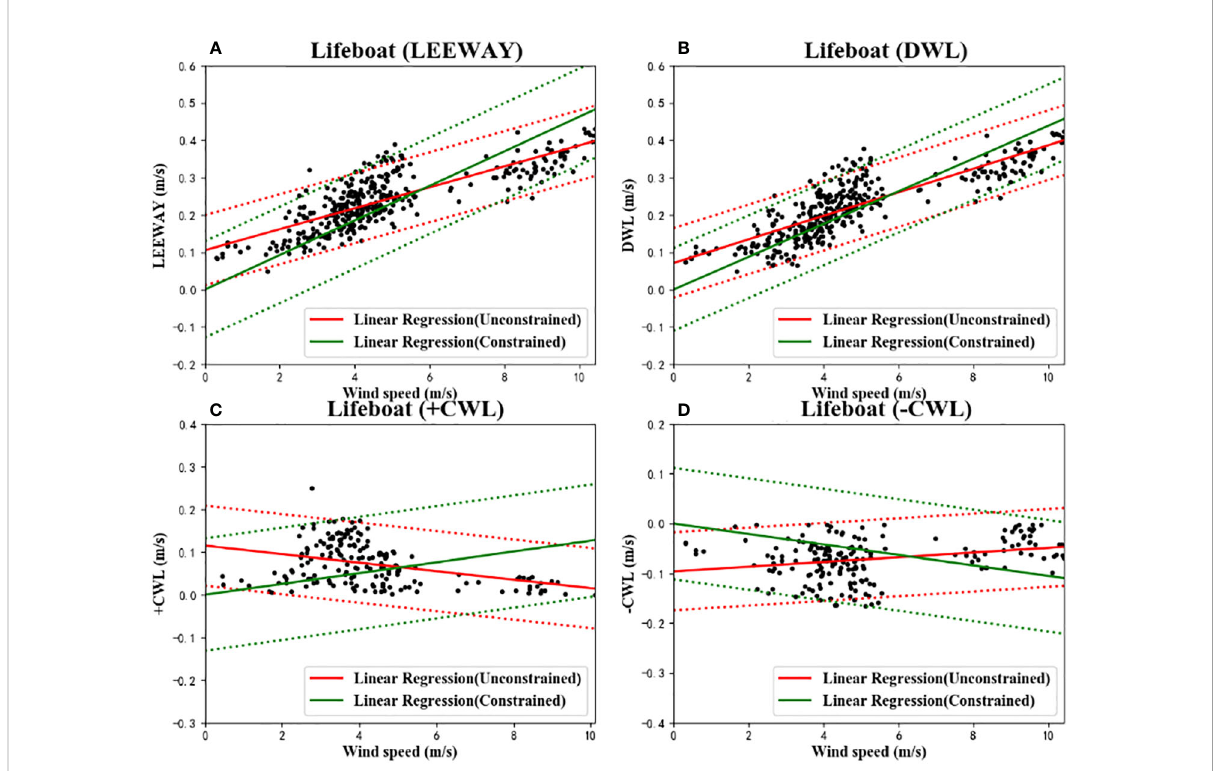
FIGURE 9 The linear regressions and 95% con fi dence level statistics of Leeway Speed (A) , DWL (B) , +CWL (C) and – CWL (D) with 10 m height wind speed for the leeway drift model. Unconstrained linear regression (solid) and 95% of the con fi dence levels (dash) are plotted in red, while constrained linear regression is plotted in green.